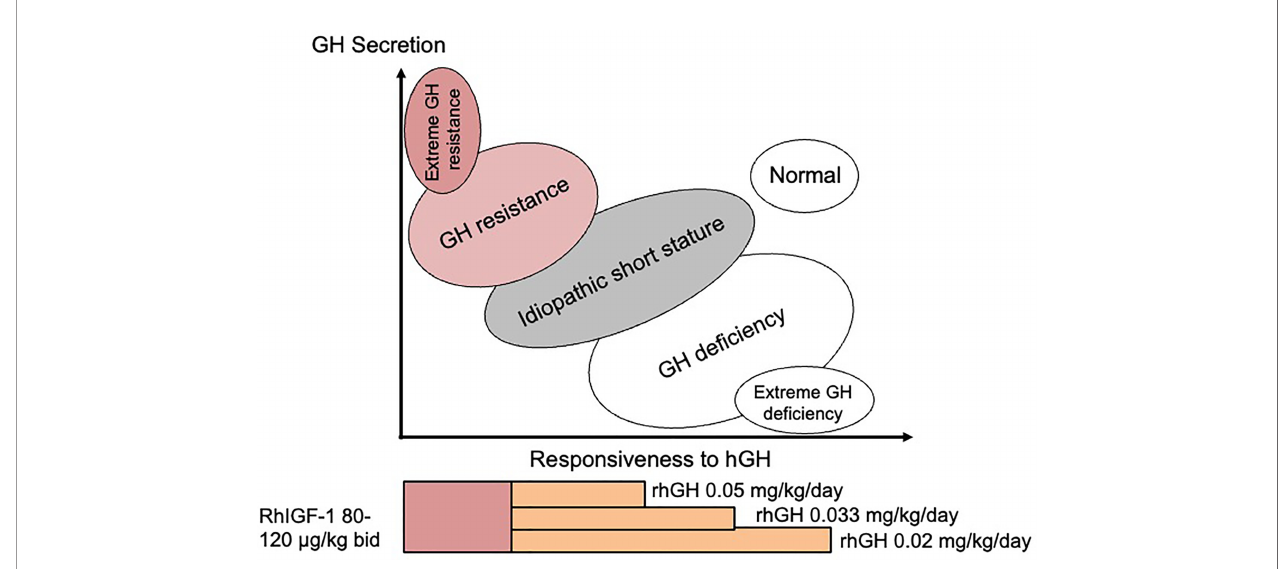
FIGURE 1 | The continuum model showing the relationship between disorders of the GH-IGF-I axis and responsiveness to hGH therapy. Suggested therapy with doses of rhGH and rhIGF-I relating to the different disorders is also